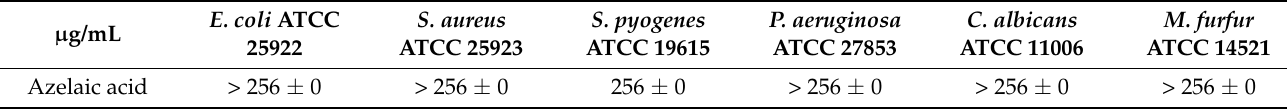
Table 5. Results of MIC assay for azelaic acid expressed in µ g/mL.